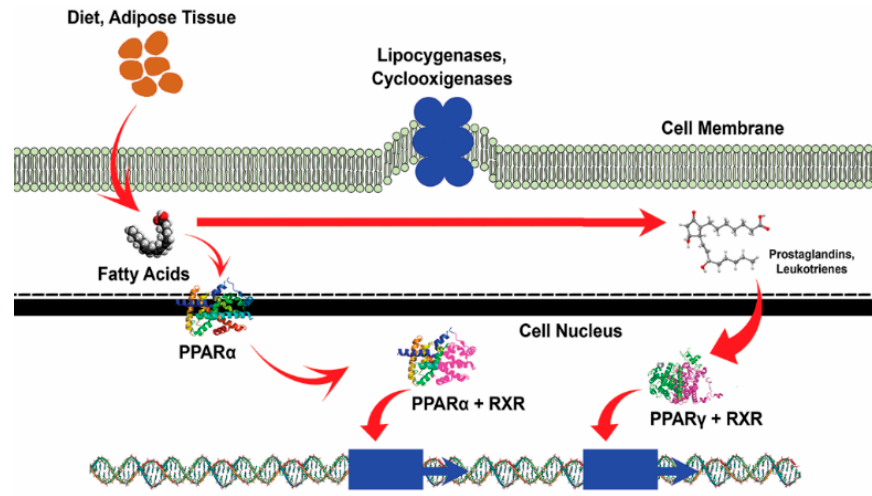
Figure 2. Proposed model of the cross-talks between PPARs and bioactive peptide in obesity. The anti-obesity activity of bioactive peptide by downregulating the expression of the nuclear transcription factor PPAR γ .